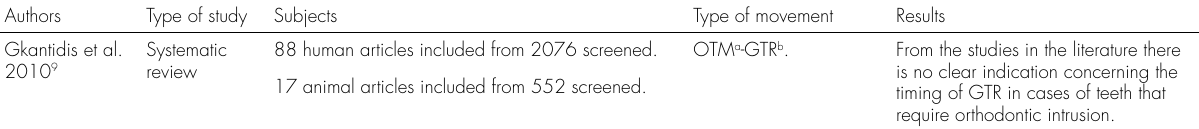
a Orthodontic Tooth Movement, b Guided Tissue